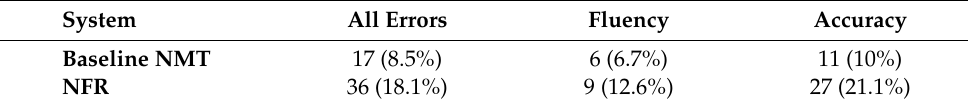
Table 15. Annotated errors that appeared in reference translations.